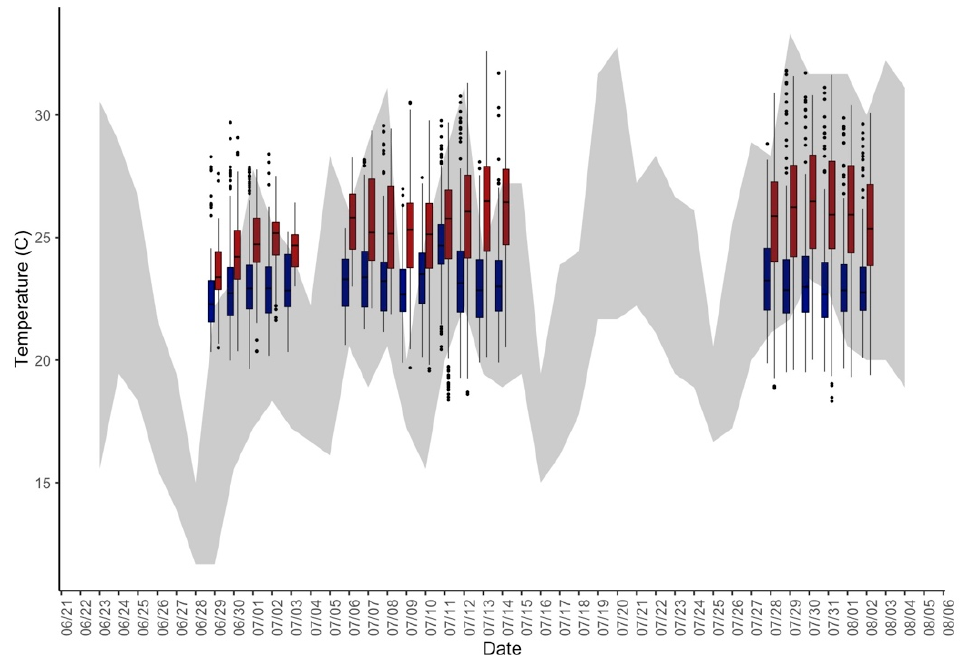
Figure 1. Indoor temperature distribution (boxplots) of non-central AC (red) and central AC (blue) groups; daily range of ambient temperature (grey shading).